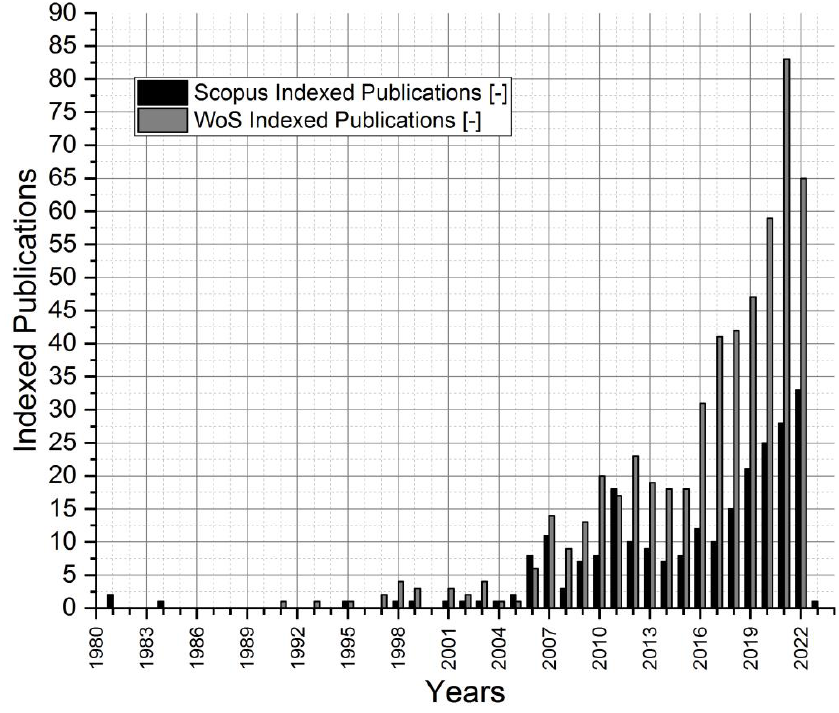
Figure 1. Literature Review on WoS and Scopus.